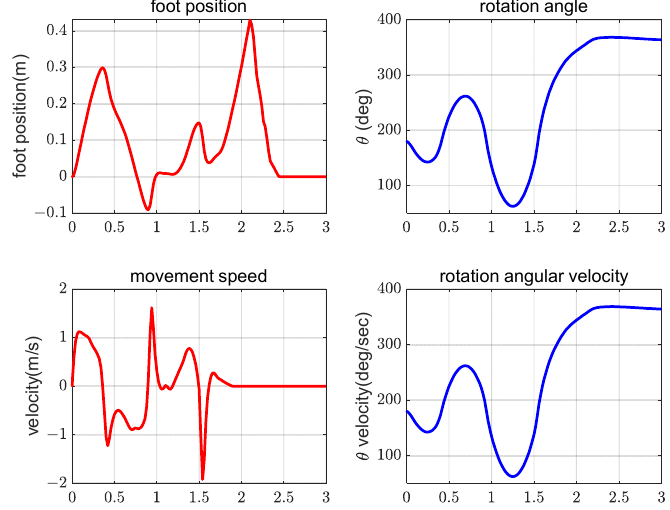
Figure 9. DDPG control without interference.